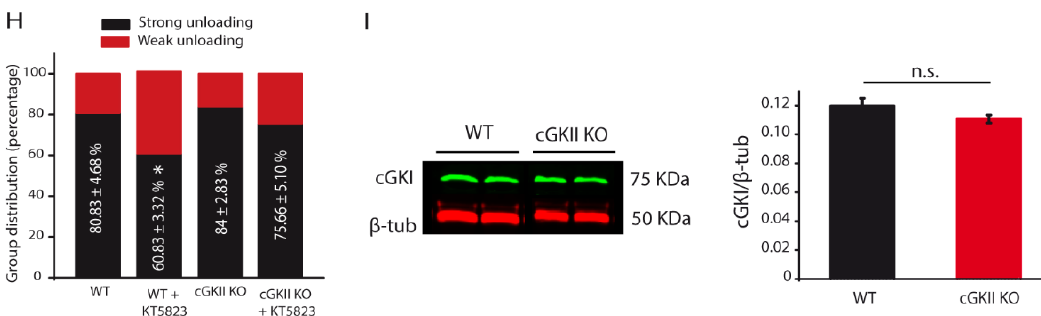
Figure 1. Efficient SV recycling in boutons from cGKII KO cells. ( A ) Fluorescence image of WT cells (left panels) loaded with FM1-43 (top amplified field) and unloaded (bottom amplified field), or those from cGKII KO mice (right panels). Bars: 10 µ m. Amplified images of the boxed areas show group 1 (white arrows) and group 2 boutons (orange arrows); ( B ) Kinetics of FM1-43 unloading of 20 randomly selected synaptic boutons during sustained stimulation with 50 mM KCl; ( C ) Mean traces of boutons from WT cells that undergo strong FM1-43 unloading ( n = 3834), from WT + KT5823 (1 µM) treated cells ( n = 2719), from cGKII KO cells ( n = 4709), and from cGKII KO + KT5823 (1 µM) treated cells ( n = 3622). Fluorescent decay was adjusted to F = F 0 + A 1 e − t/ τ 1 + A 2 e − t/ τ 2 , where τ 1 and τ 2 are the time constants for dye unloading ( τ 1WT = 4.76 ± 1.24 s and τ 2WT = 59.24 ± 5.31 s; τ 1WT + KT = 4.36 ± 0.90 s and τ 2WT + KT = 52.44 ± 5.92 s; τ 1KO = 3.30 ± 1.06 s and τ 2KO = 57.69 ± 4.27 s; τ 1KO + KT = 3.82 ± 1.06 s and τ 2KO + KT = 52.97 ± 5.93 s). ( D ) Mean traces of weak FM1-43 unloading boutons from WT cells ( n = 827), from WT + KT5823 (1 µM) treated cells ( n = 1704), from cGKII KO cells ( n = 862), and from cGKII KO + KT5823 (1 µM) treated cells ( n = 1152). ( E ) Graphical representation of the time constants for fluorescence decay of weak unloading boutons shown in panel D. Fluorescent decay was adjusted as indicated above, * p = 0.012 and *** p ≤ 0.001 represents significant differences against WT. ## p = 0.0068 and ### p ≤ 0.001 represents significant differences against cGKII KO without KT5823. ( F ) Comparison of FM1-43 uptake (total height of bars), released (striped bars) and residual staining (filled bars) in boutons corresponding to the strong unloading group from WT cells ( n = 5 coverslips), WT cells incubated with KT5823 for 24 h (1 µM, n = 6 coverslips), cGKII KO cells ( n = 7 coverslips) and cGKII KO cells incubated with KT5823 for 24 h (1 µM, n = 6 coverslips), expressed as the mean intensity (±SEM) from individual experiments (coverslips from three different cultures: *** p ≤ 0.001 initial fluorescence or residual fluorescence compared to WT or without KT5823; ### p ≤ 0.001 initial fluorescence or residual fluorescence compared to cGKII KO without KT5823; +++ p ≤ 0.001 initial fluorescence or residual fluorescence comparing WT vs. cGKII KO; ( G ) Comparison of FM1-43 uptake (total height of bars), release (striped bars) and residual staining (filled bars) in boutons corresponding